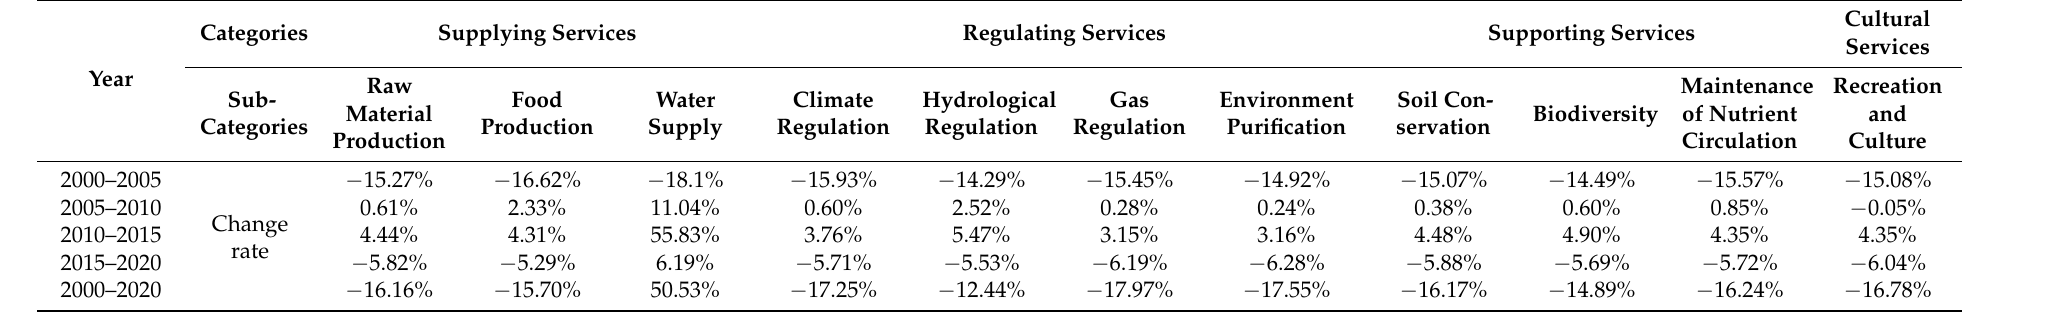
Table 10. Rate of change in ESV by different categories of ecosystem services in Hainan